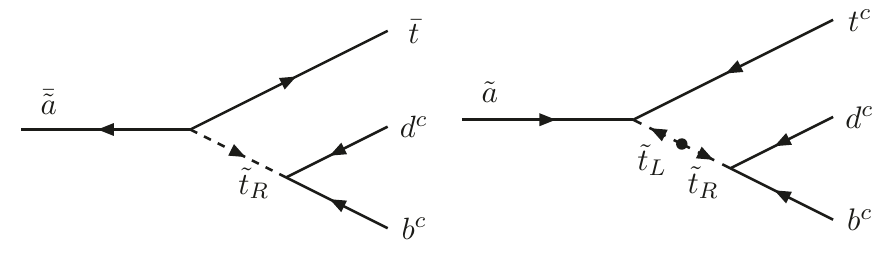
Figure 2 . Tree-level diagrams for the decays of DFSZ type axino,